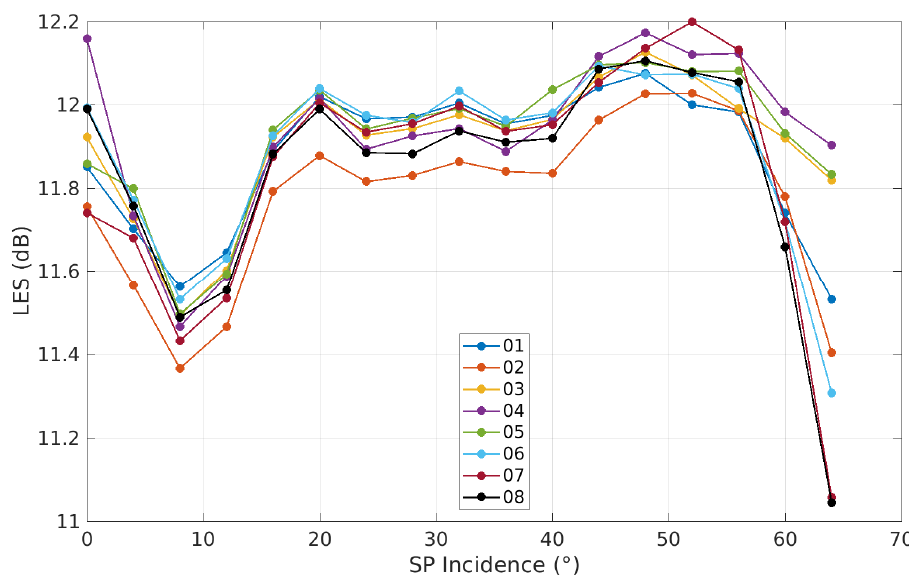
Figure A2. Dependence of LES on incidence angle (from nadir 0° to 65°) at U10 ~7m/s, for all SVNs, segmented by CyGNSS Flight Model (FM01-FM08).